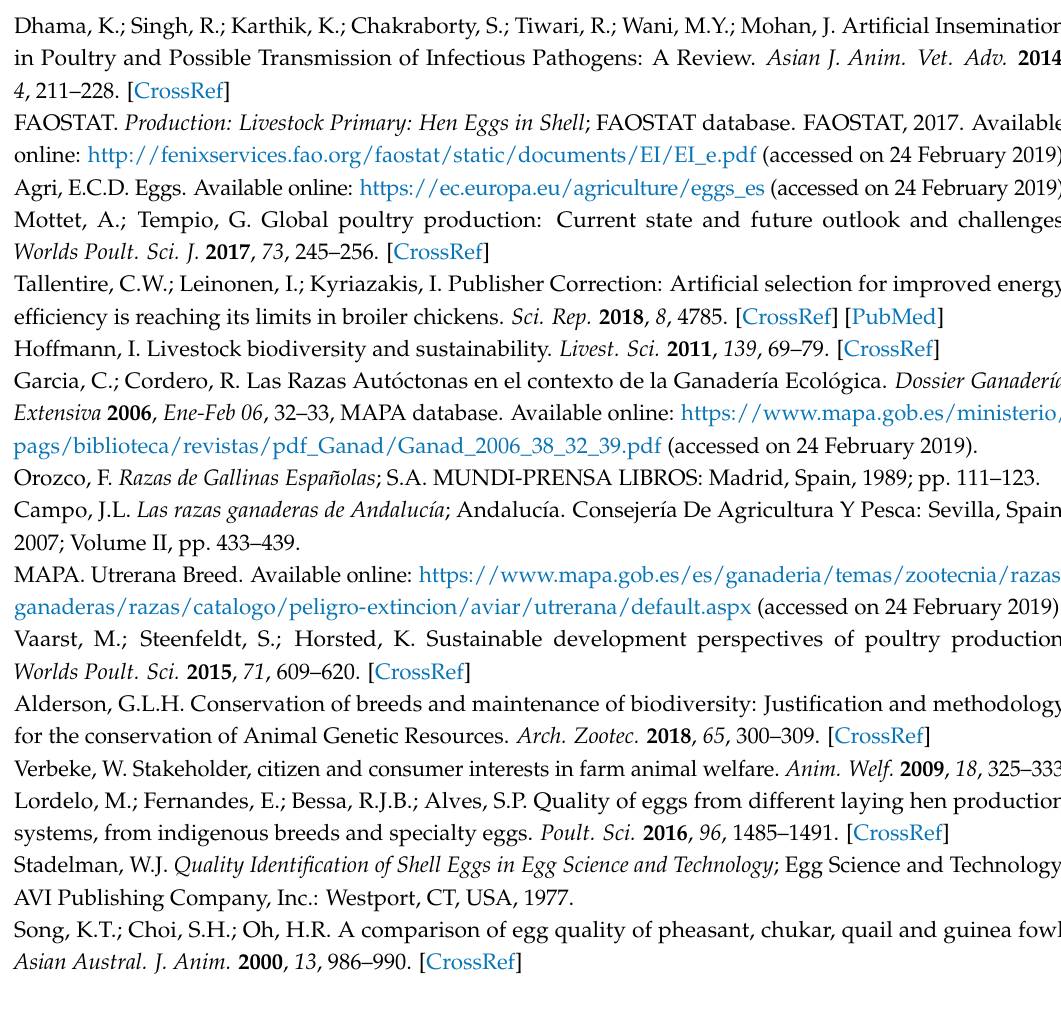
Table S8: Pearson product-moment correlation coefficient between external and internal egg quality-related traits in Utrerana hens compared to laying lineage in two models, including (n = 97) and excluding (n = 194) yolk and white pH; Table S9: Standardized canonical coefficients of variables, canonical correlations between two sets of variables (r), squared canonical correlation (r2) and their probabilities (F) for internal and external egg quality-related traits including yolk and white pH in Utrerana hens compared to laying lineage (n = 97); Table S10: Correlations between the variables and related canonical variables (canonical loadings) and between the variables and the other set of canonical variables (canonical cross-loadings) for internal and external egg quality-related traits including yolk and white pH in Utrerana hens compared to laying lineage (n = 97); Table S11: Proportion of explained variance, eigenvalues and percentages of explained common variance associated with each factor of internal and external egg quality-related traits including yolk and white pH in Utrerana hens compared to laying lineage (n =